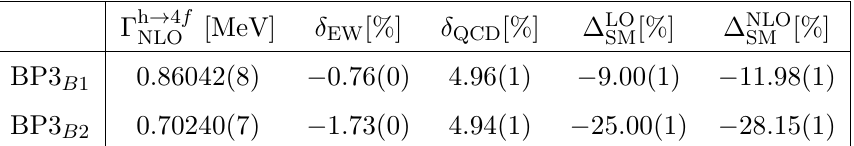
Table 11 . The h 4 f widths in the MS( (cid:21) 3 ) scheme, including the EW and QCD corrections in the ! benchmark scenarios BP3 B 1 ;B 2 (with the numerical errors in parentheses). The last two columns show the deviation from the SM prediction at LO and